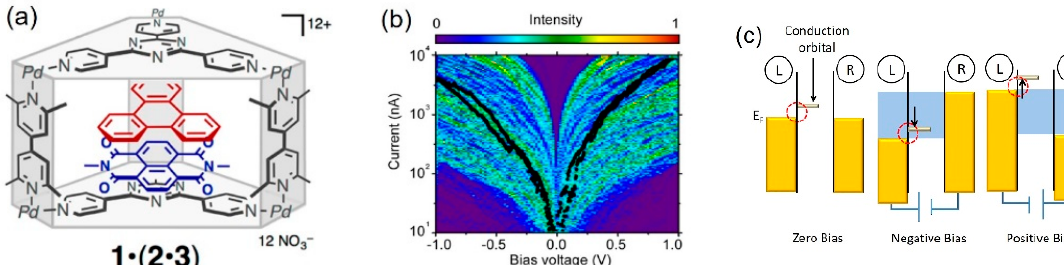
Figure 2. The single-molecule diode with the heterocomplex. ( a ) The naphthalenediimide and triphenylene are accommodated in the columnar cage. ( b ) Distribution of I – V curves of the heterocomplex single-molecule junctions, constructed from 500 I – V traces. Black lines are examples of I – V curves. ( c ) Energy diagram of the single-molecule diode. The conduction orbital is lowest unoccupied molecular orbital (LUMO), and the electronic coupling between LUMO and left electrode is larger than that of the right electrode. Reproduced with permission from [27], copyright Journal of the American Chemical Society Group 2015.